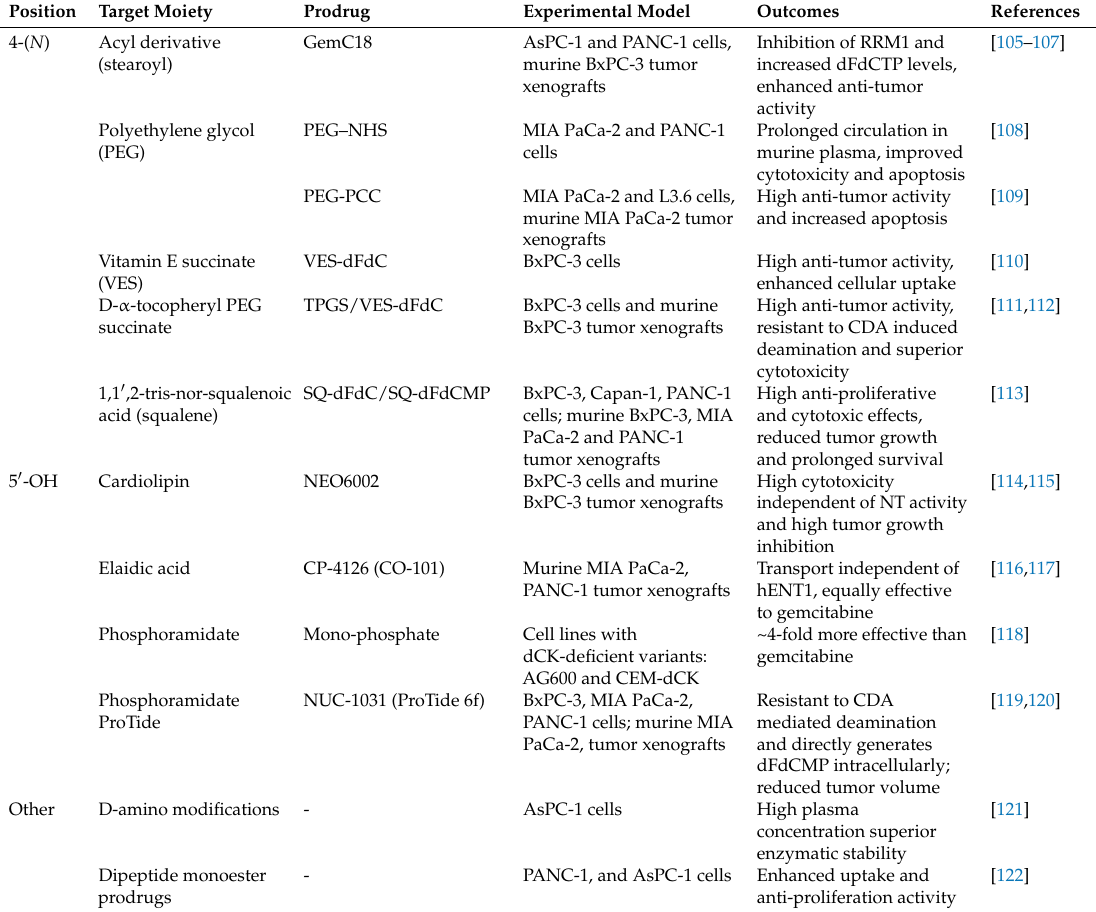
Table 2. Modifications of the gemcitabine molecule and their outcome in pancreatic